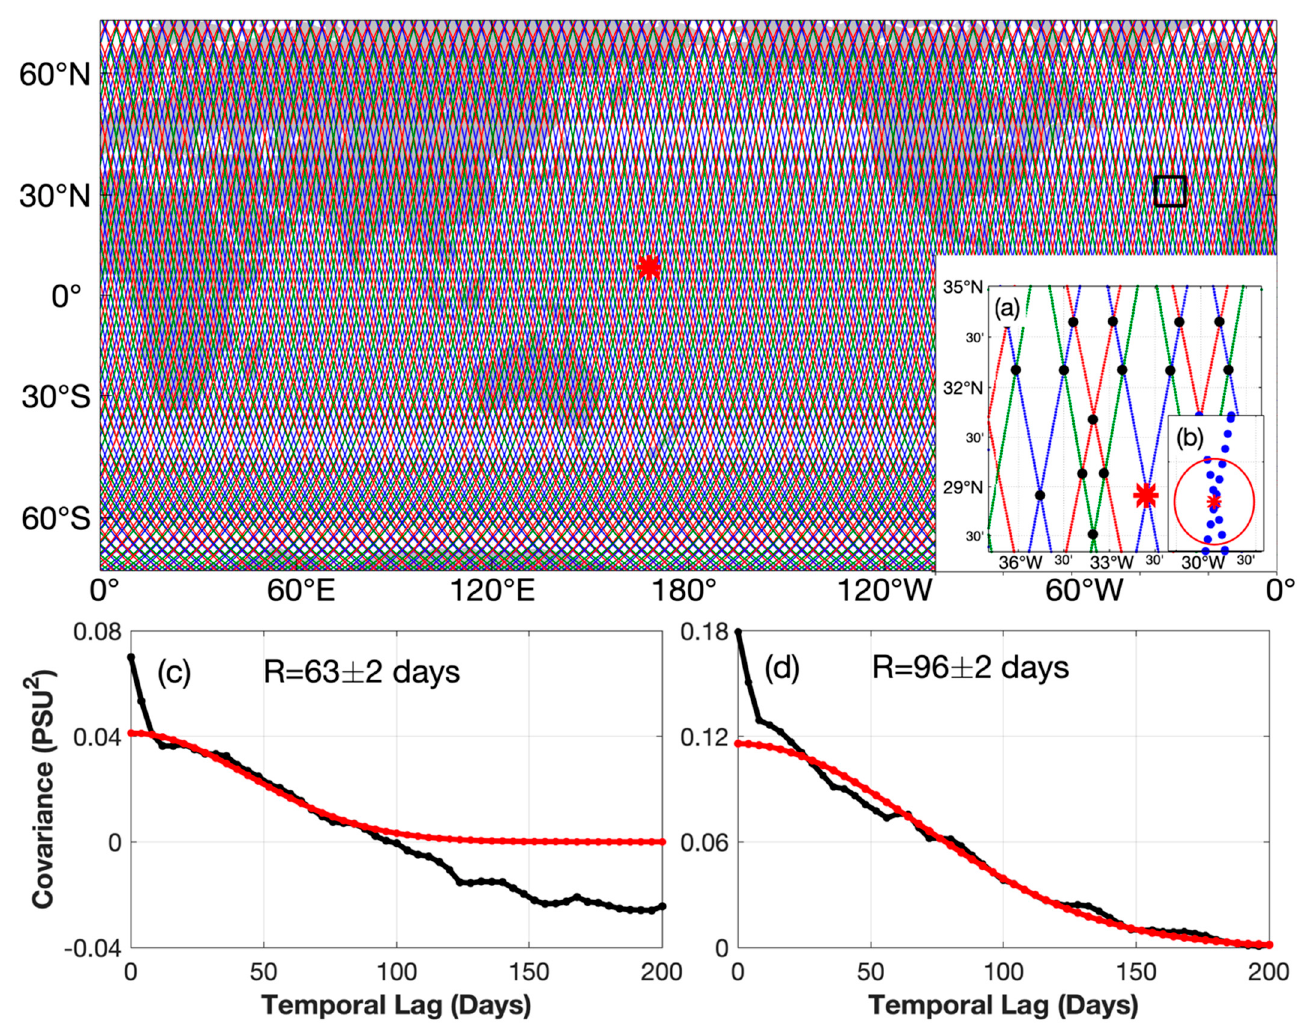
Figure 1. Background: Sample pattern of Aquarius ground tracks over a 7-day repeat cycle. The three beams are displayed in different colors. The combination of ascending and descending satellite passes forms crossover points shown by black dots. A zoom over the area in the subtropical North Atlantic (black rectangle) is provided in panel ( a ). Panel ( b ) shows locations of SSS measurements around one crossover point (red asterisk). To reduce the instrument noise, measurements of SSS in the radius of 0.25° from a crossover point (red circle) are averaged together. Panels ( c , d ) show examples of SSS autocovariance functions estimated in two regions located at the subtropical North Atlantic (left) and the tropical Pacific (right). The black curve shows the SSS autocovariance and the red curve is the Gaussian function fitted to the initial segment of the empirical autocovariance starting from the first lag (time lag = 4 days) and to the first zero-crossing.